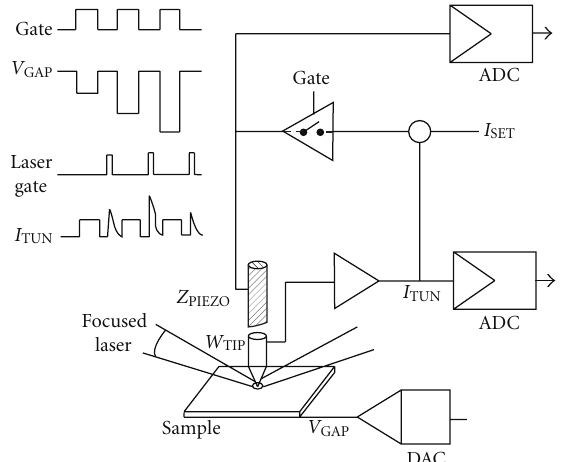
Figure 11: E ff ect of tip radius on the rectification ratios. The calculations are done for: ρ = ∞ , that is, planar-planar junction, included as a reference (solid), (b) ρ = 10 nm (dotted), (c) ρ = 2 nm (dashed), (d) ρ = 1nm (dot-dashed), (e) ρ = 0 . 5nm (dot-dot dashed), and for the separation of 2nm